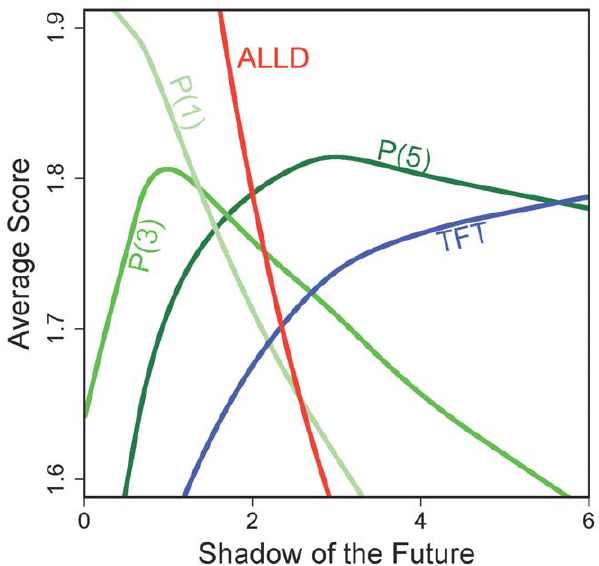
Figure 3. Prejudiced strategies outperform TFT and ALLD for intermediate shadows of the future. Average score of various strategies as a function of the shadow of the future. TFT performs best when the horizon is long. ALLD, on the other hand, performs best when the horizon is short. For any intermediate shadow of the future, prejudiced strategies (such as P(5)) obtain higher average scores than either ALLD or TFT. The results are based on 100 simulations with 50% TFT, 50% ALLD and one prejudiced player.